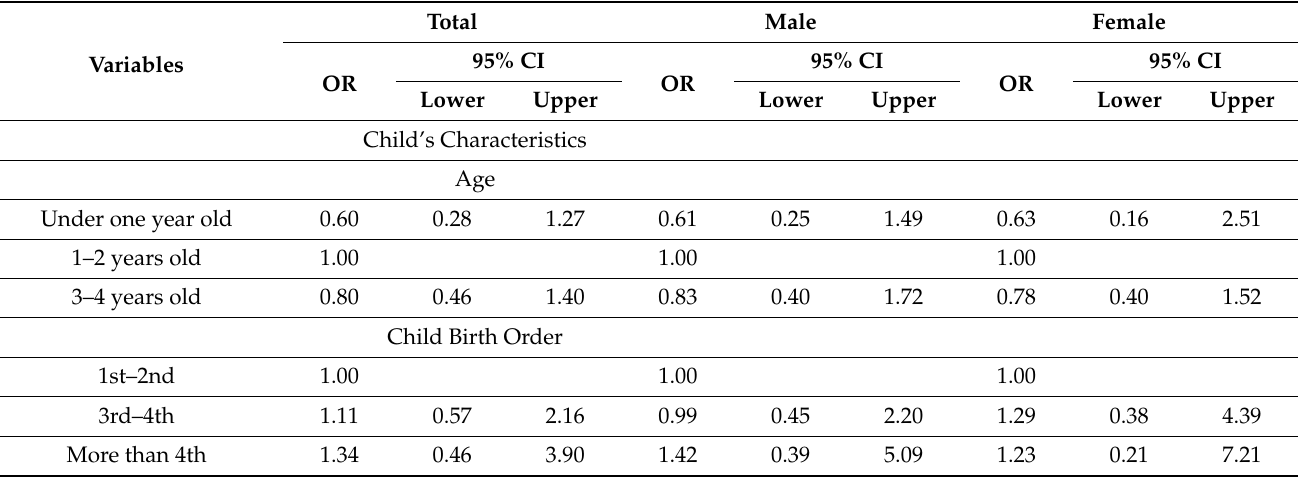
Table 4. Predictions of children with ARI symptoms in the Philippines compared by gender in